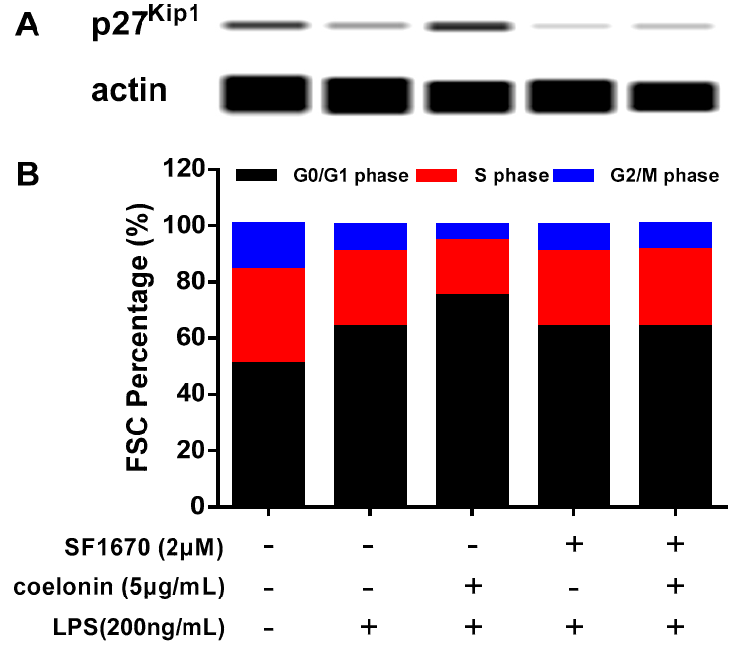
Figure 8. ( A ) Western blotting result of p27 kip1 . RAW264.7 cells were incubated with solvent or 200 ng / mL LPS for 12 h in the absence or presence 5 µ g / mL of coelonin or 2 µ M of the PTEN inhibitor SF1670 or 2 µ M of SF1670 combined with 5 µ g / mL of coelonin. Then total cellular protein was extracted and analysed by a simple western immunoblotting technique on a Peggy Sue system. ( B ) Coelonin induce G1 cell cycle arrest through PTEN analysed by flow cytometry. RAW264.7 cells were incubated with solvent or 200 ng / mL LPS for 12 h in the absence or presence 5 µ g / mL of coelonin or 2 µ M of the PTEN inhibitor SF1670 or 2 µ M of SF1670 combined with 5 µ g / mL of coelonin. Cells were harvested, fixed and stained with PI, and cell cycle distributions were analyzed on a BD Accuri ™ C6 flow cytometer in triplicate.